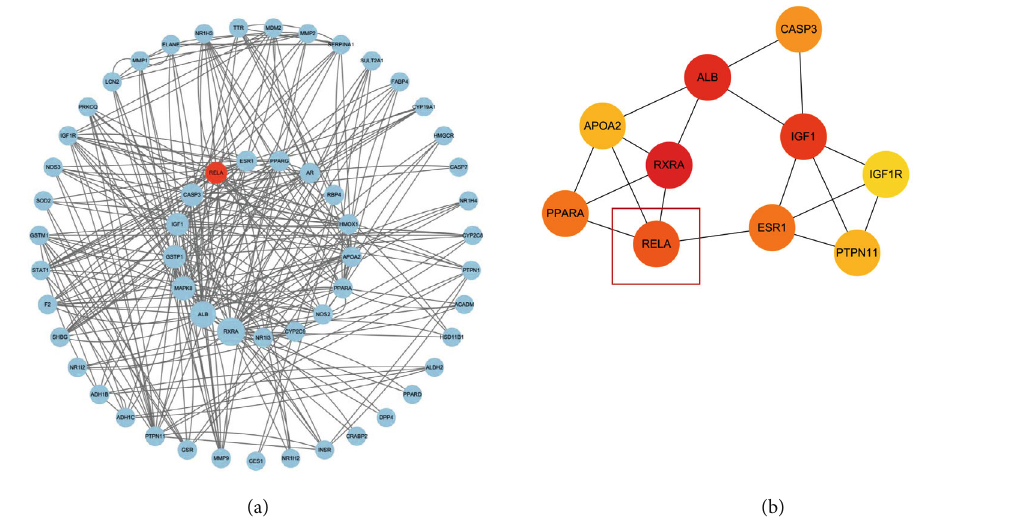
Figure 3: (a) Cytoscape treated protein interaction network. (b) The top ten protein interaction networks obtained by the degree algorithm.